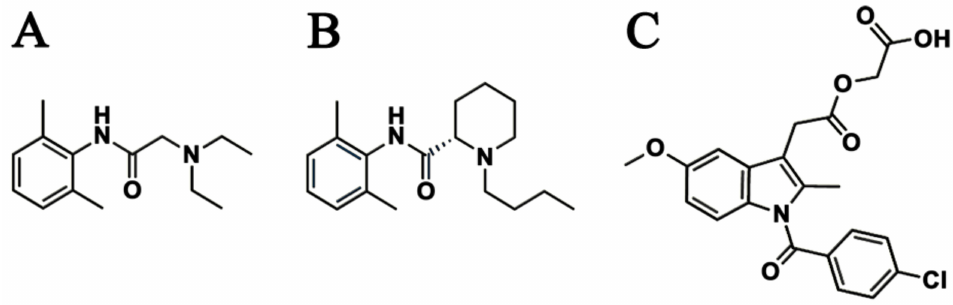
Figure 1. Chemical structures of (A) lidocaine, (B) levobupivacaine, and (C)